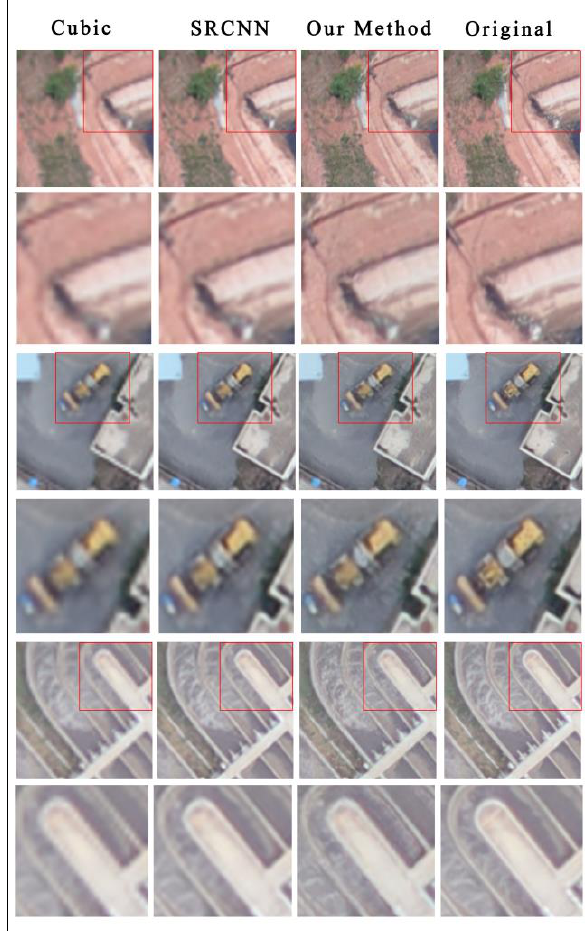
Figure 3. The local image details from SR reconstruction results and corresponding reference HR